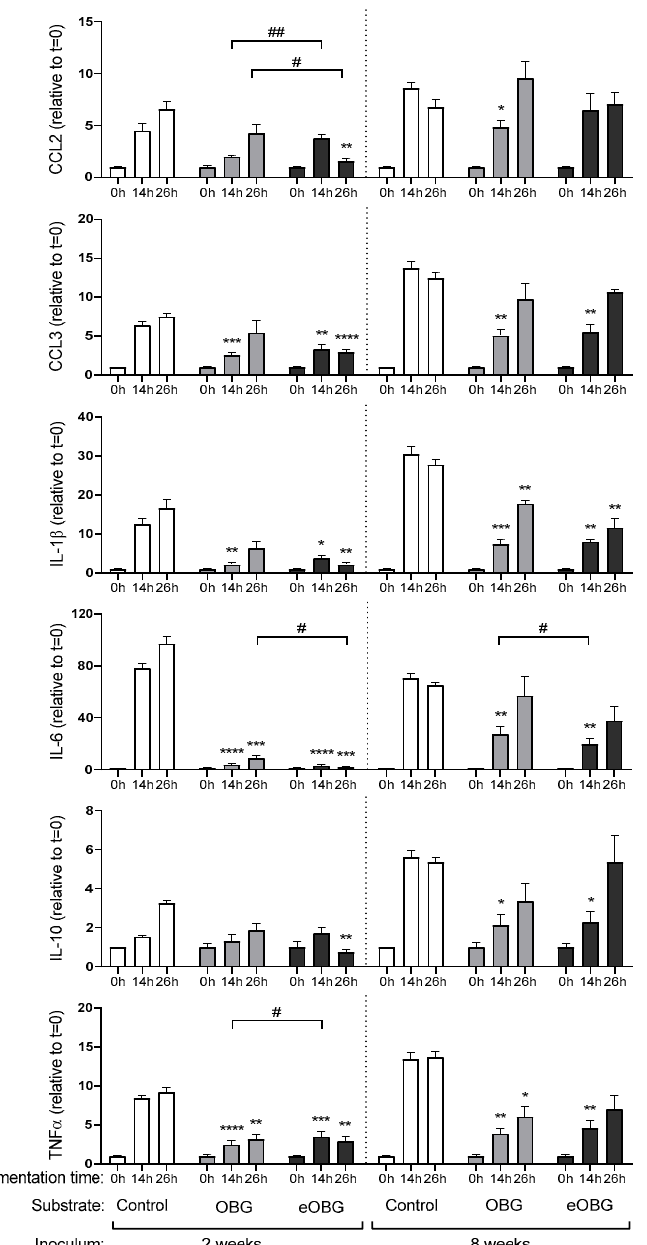
Figure 5. Induced cytokines (fold change of induction by 0 h sample) by digesta of control fermentation, native oat β -glucan (OBG) and enzyme-treated oat β -glucan (eOBG) fermentation with pooled fecal inocula of 2- and 8-week-old infants. Statistical di ff erences were tested using a mixed-e ff ects model (REML) test followed by a Tukey’s multiple comparison test. Stars above bars represent statistical di ff erences compared to the time-matched control samples (* p < 0.05, ** p < 0.01, *** p < 0.001, **** p < 0.0001). Statistical di ff erences between samples of OBG and eOBG fermentations are indicated above graphs (# p < 0.05, ## p < 0.01, ### p < 0.001, #### p < 0.0001) ( n = 6).